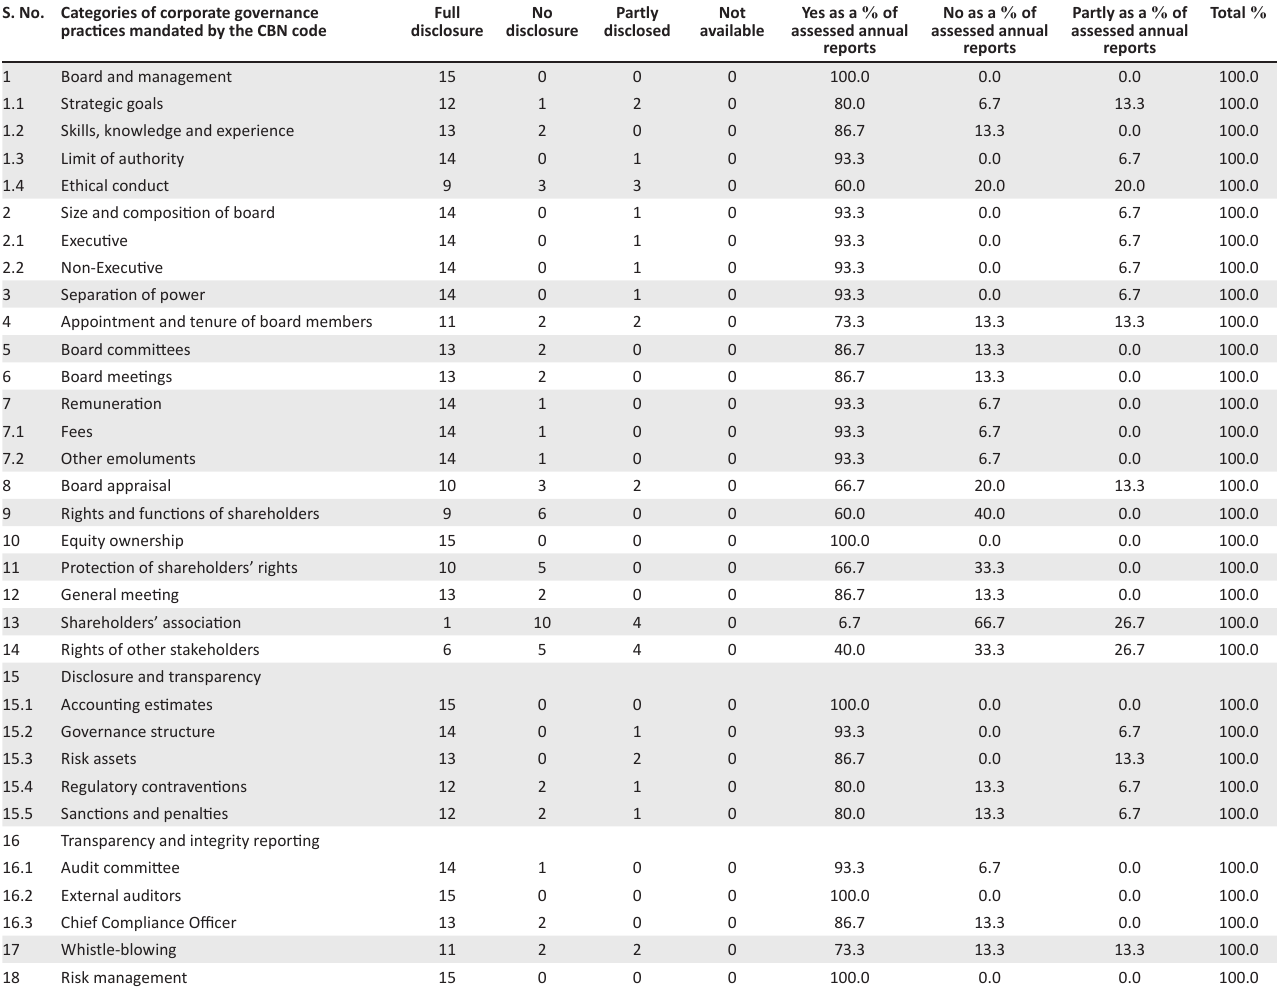
TABLE 5: Content analysis: 2016 Annual Reports of Nigerian banks. S. No. Categories of corporate governance practices mandated by the CBN